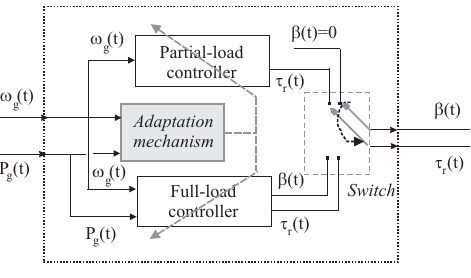
Figure 6. Diagram of the adaptive control